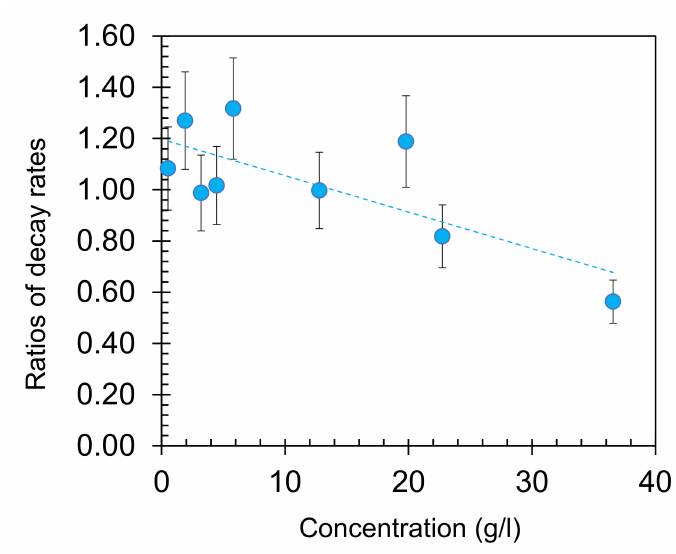
Figure 6. The ratios of the emission decay rates measured on top of smooth thermally deposited Au films and on top of glass, plotted as the function of the dye concentration. The dashed line is the linear fit of the data points—guide for eye.